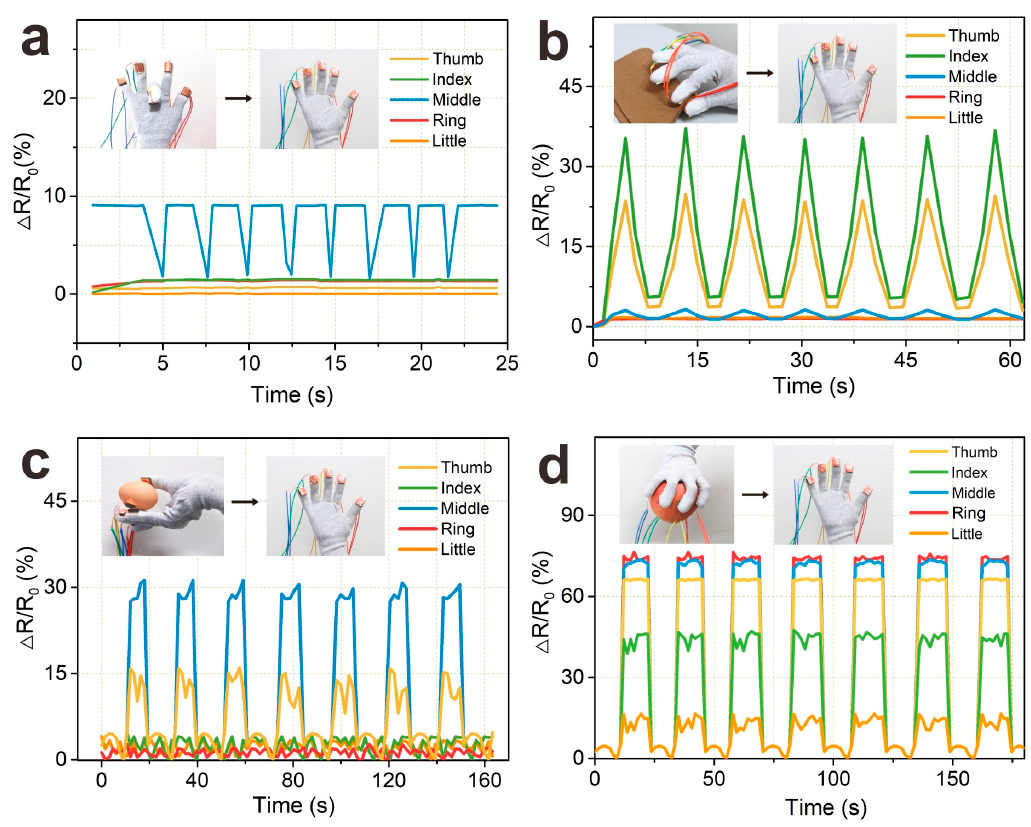
Figure 8. Relative resistance variation of AgNWs / NRLF under cyclically hand gestures, including ( a ) middle finger bending; ( b ) touching fabric; ( c ) holding egg; ( d ) holding apple.